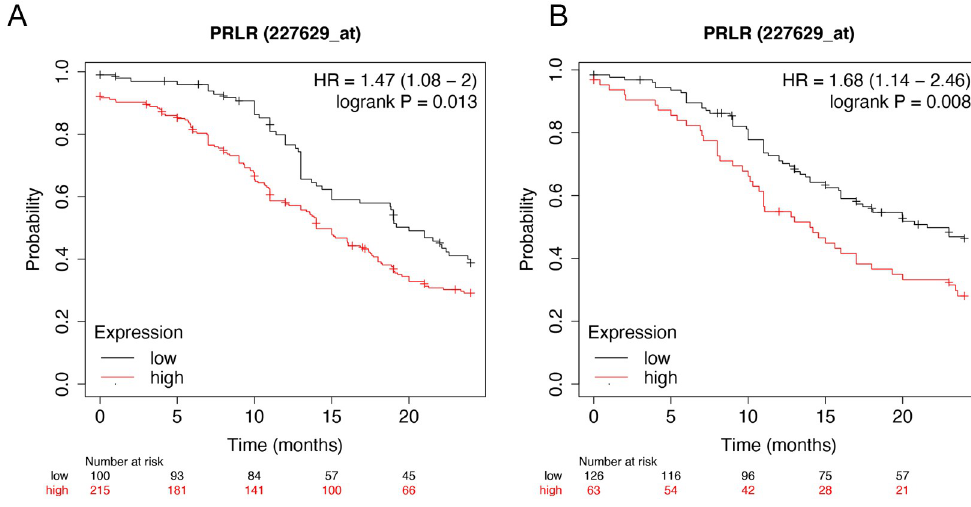
Fig 1. Kaplan Maier survival curve based on PRLR mRNA